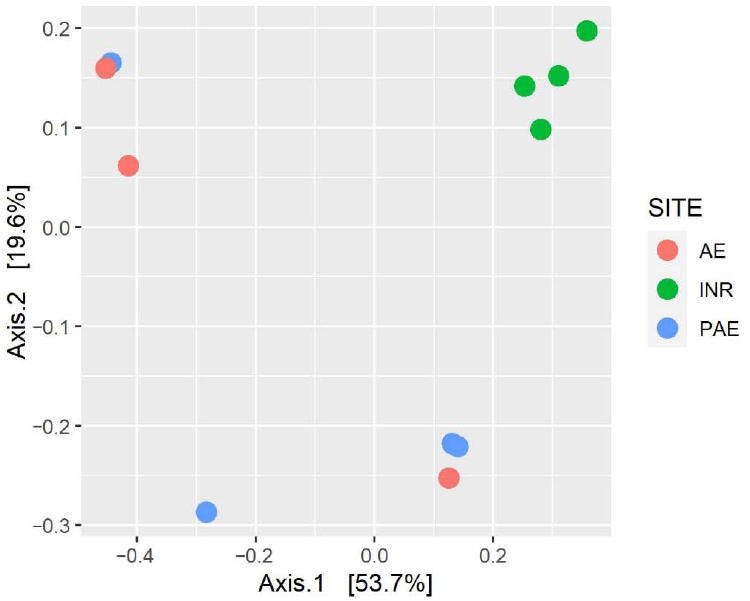
Figure 8. Principal coordinate analysis (PCoA) based on unweighted UNIFRAC distance matrix of Illumina MiSeq sequencing fungal data of soil samples taken from the AgroEcosystem (AE), the Polluted AgroEcosystem (PAE) and the Integral Natural Reserve (INR).